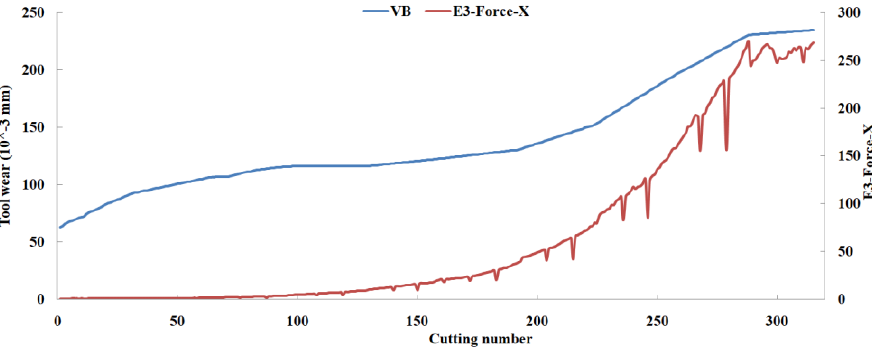
Figure 14. The scatter diagram between E 3 in X-dimension Force and tool wear value.